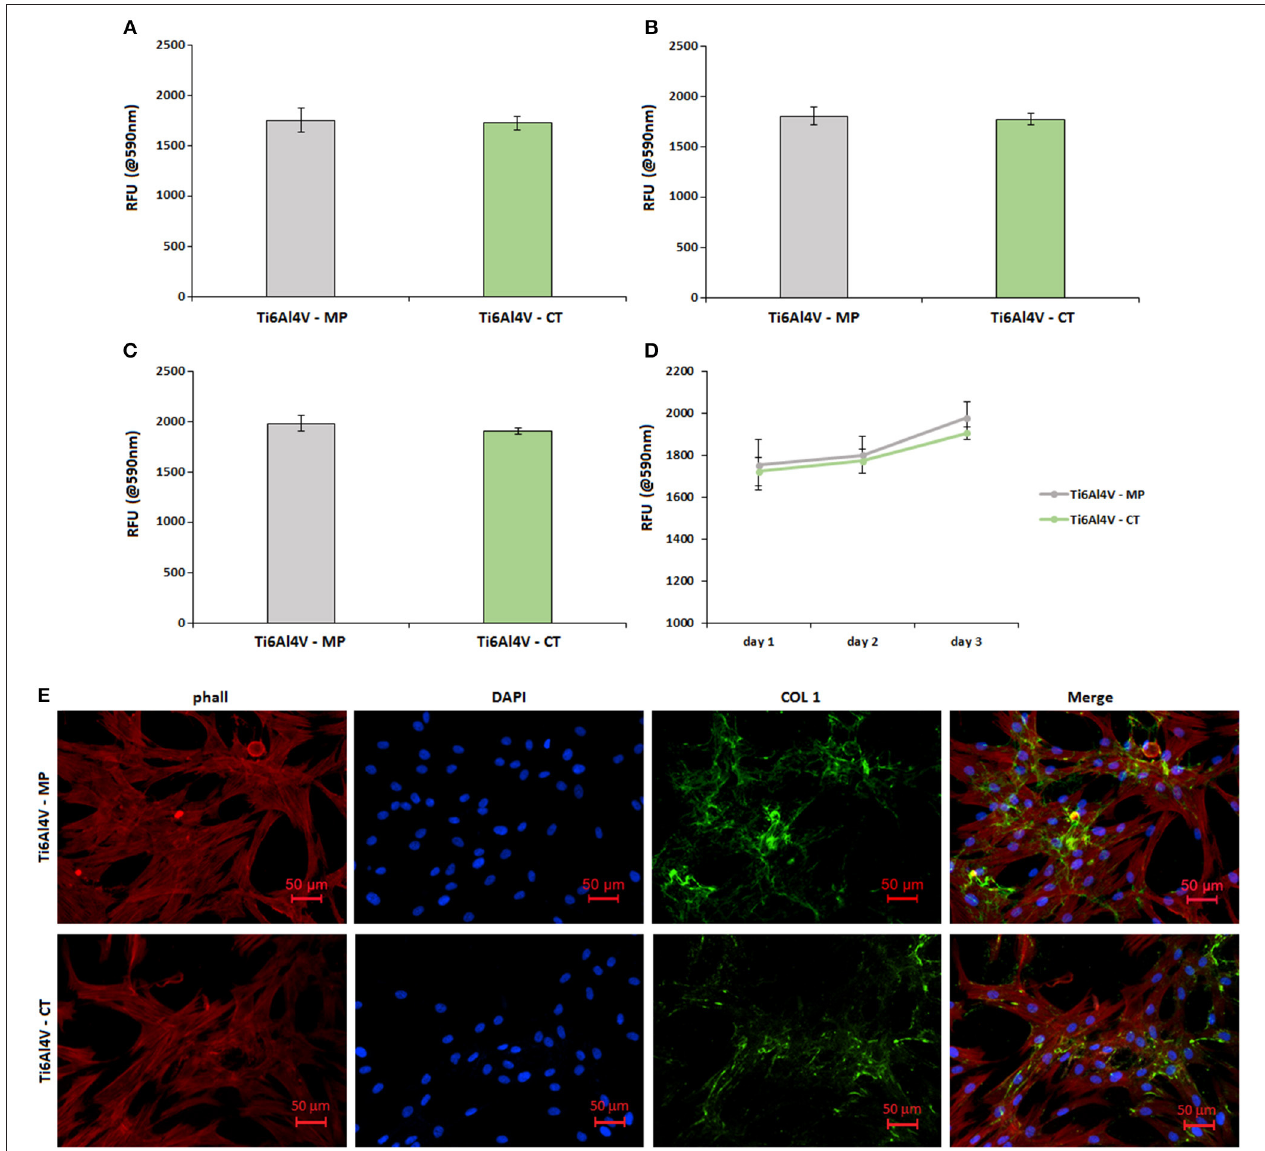
FIGURE 7 | Cytocompatibility evaluation. No differences were noticed in terms of cells viability between the untreated control (Ti6Al4V—MP) and the treated specimens (Ti6Al4V—CT) after 1 (A) , 2 (B) , and 3 (C) days of direct cultivation; result were comparable and not significant ( p > 0.05) as summarized in (D) . Moreover, cells were able to deposit matrix onto both surfaces as demonstrated by the evident collagen I (COL 1) accumulation after 3 days (E) . Bars represent means and standard deviations.